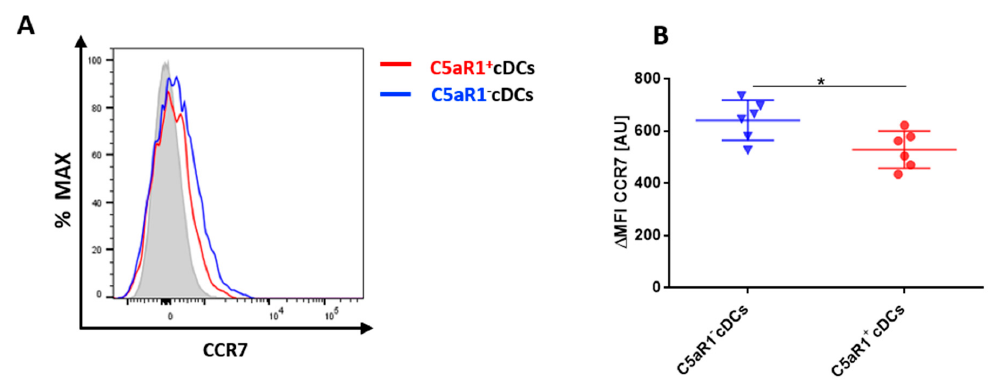
Figure 5. CCR7 expression in pulmonary C5aR1 + and C5aR1 − cDCs ( A ) Histogram showing the expression of CCR7 in C5aR1 + and C5aR1 − cDCs FACS-sorted 24 h after i.t. HDM / OVA immunization